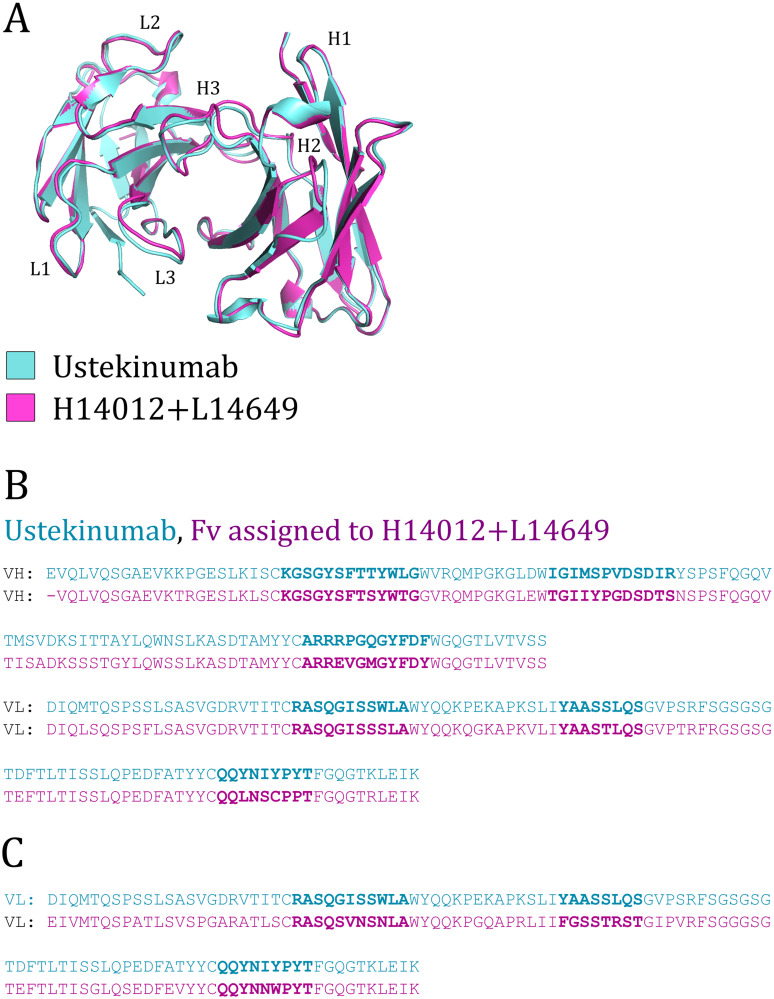
(A) Alignment of the solved Ustekinumab crystal structure (3hmw) and the closest Public Baseline AML structure (H14012+L14649). (B) Comparison of the Ustekinumab Fv sequence and a Gidoni et al. naïve Fv sequence assigned by Repertoire Structural Profiling to the H14012+L14649 Public Baseline structure. The North-defined CDR regions of each chain are highlighted in bold. (C) An alternative VL sequence coupled to the same Gidoni VH sequence. This sequence has a more sequence similar CDRL3 but a less similar CDRL2.